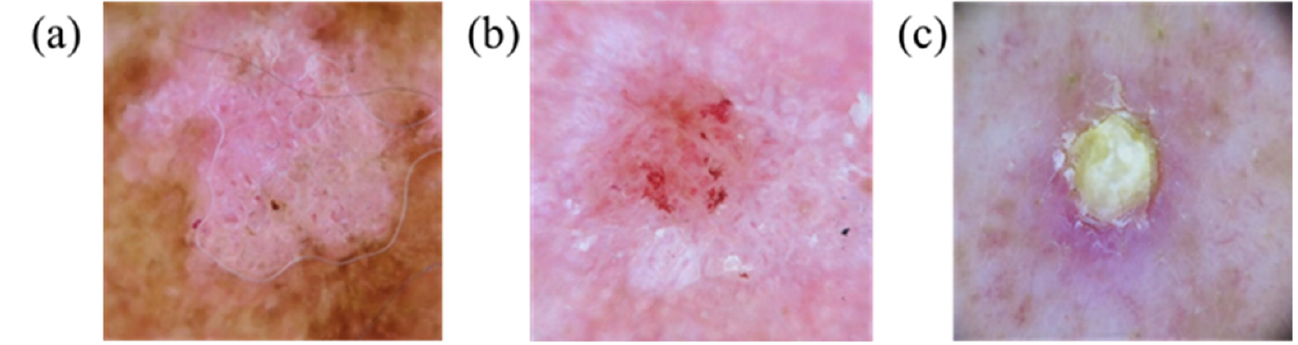
Figure 2. Basal cell carcinoma: ( a ) bright protrusions around the epidermis and ( b , c ) enlarged and frequently hemorrhagic